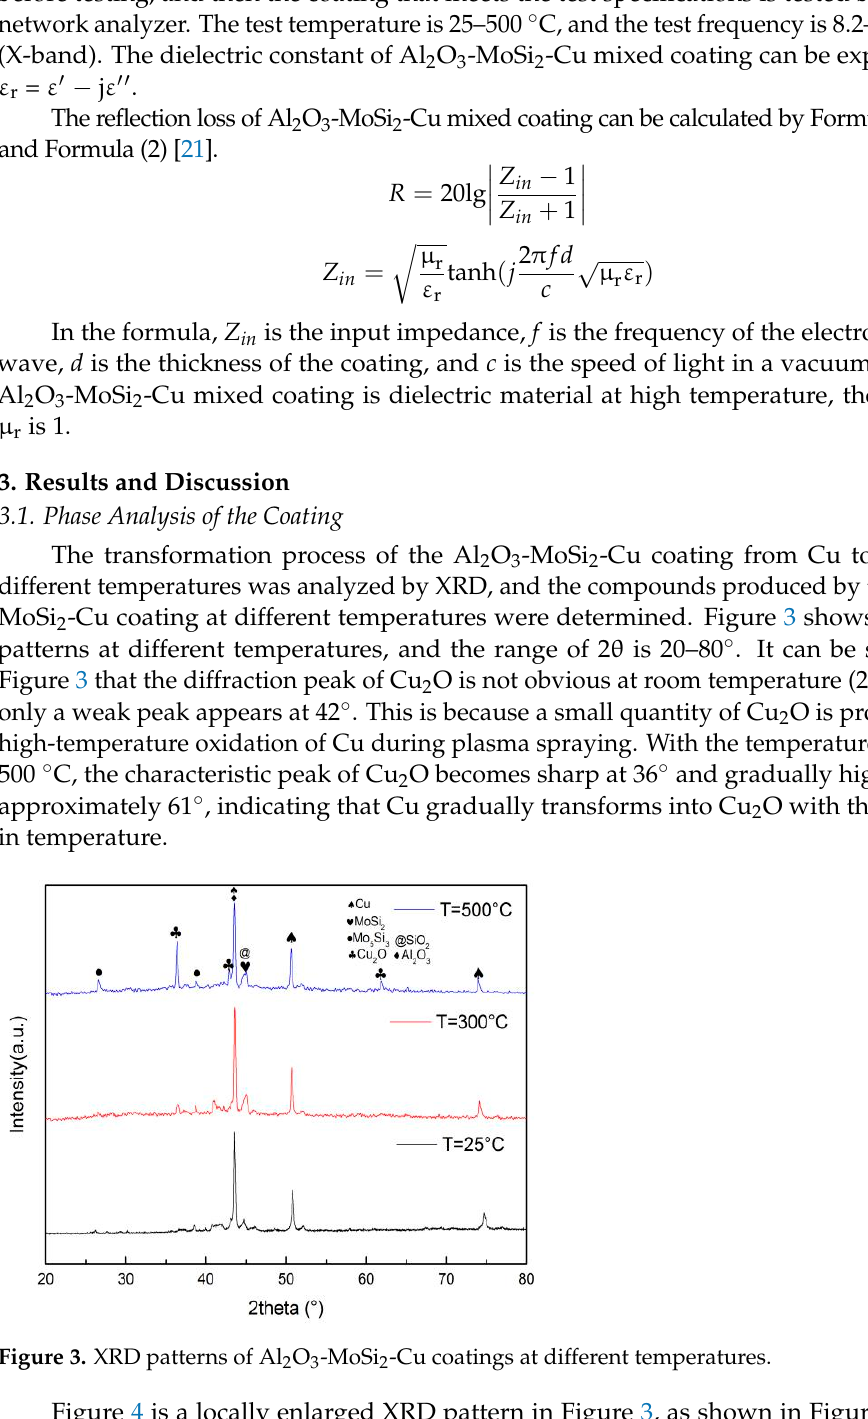
Figure 4. Figure 3 locally enlarged graphs in the range of 2 θ from 35° to 38°. 3.2. Thermal Analysis Thermogravimetric analysis of Al 2 O 3 -MoSi 2 powder and Al 2 O 3 -MoSi 2 -Cu powder was performed by thermal analyzer, with a test temperature from room temperature (25 °C) to 1000 °C and a heating rate of 10 degrees Celsius per minute. MoSi 2 and Al 2 O 3 are selected because MoSi 2 has good high-temperature resistance and is commonly used in high-temperature structures in the aerospace field. However, with the increase in temper- ature, the “pesting“ phenomenon [22] usually occurs at 400 to 600 °C, and the appropriate mixing of Al 2 O 3 in MoSi 2 can effectively prevent the MoSi 2 occurrence of pulverizing in the coating surface. In Figure 5, the black curves show the weight change trend of Al 2 O 3 - MoSi 2 powder during heating. It can be seen that Al 2 O 3 -MoSi 2 powder increases with tem- perature, and the weight of powder remains stable below 500 °C. When Al 2 O 3 -MoSi 2 pow- der rises from 500 to 800 °C, the mass of powder increases by 1.36%. When the tempera- ture of Al 2 O 3 -MoSi 2 powder changes from 800 to 1000 °C, it goes through a process of decrease and increase, and, finally, remains at approximately 100%. It can be seen from